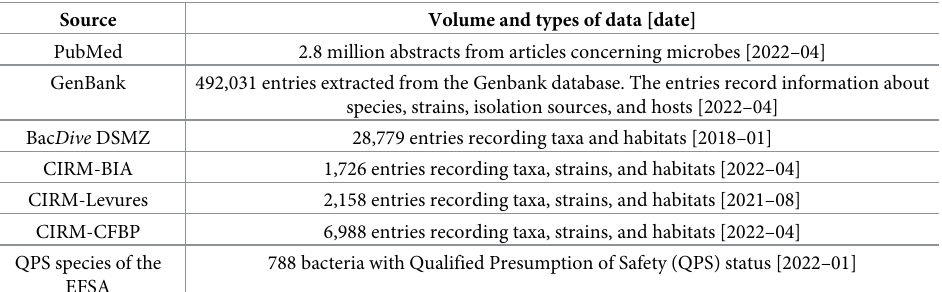
Table 2. Omnicrobe sources, data volumes, types, and extraction dates in the May 2022